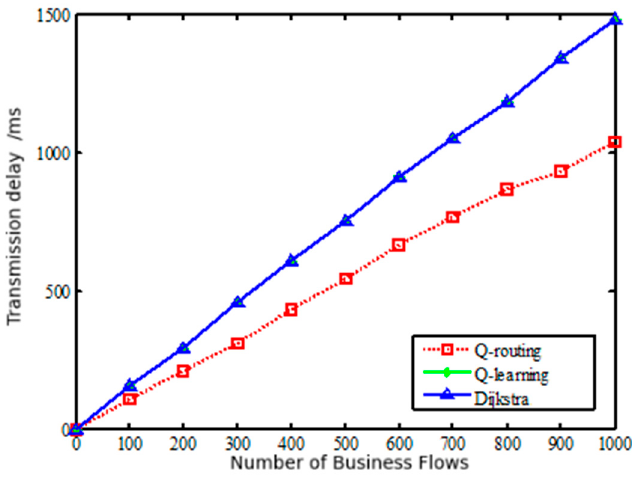
Figure 15. Comparison of transmission delays of delay-sensitive services under different routing algorithms.